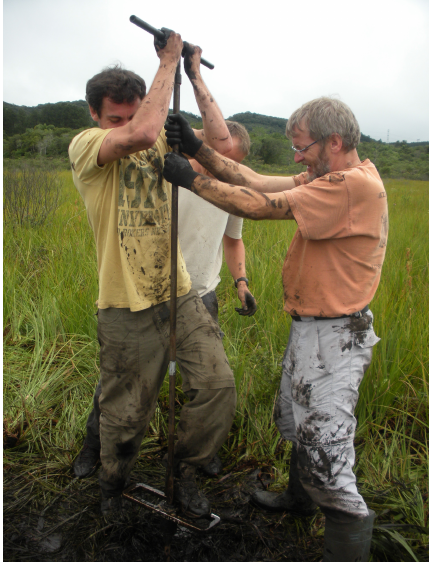
Figure 3. The drilling of core CO 14-1 performed during the excur- sion to the structure of Colônia. Photo credit: Marie-Pierre Ledru.